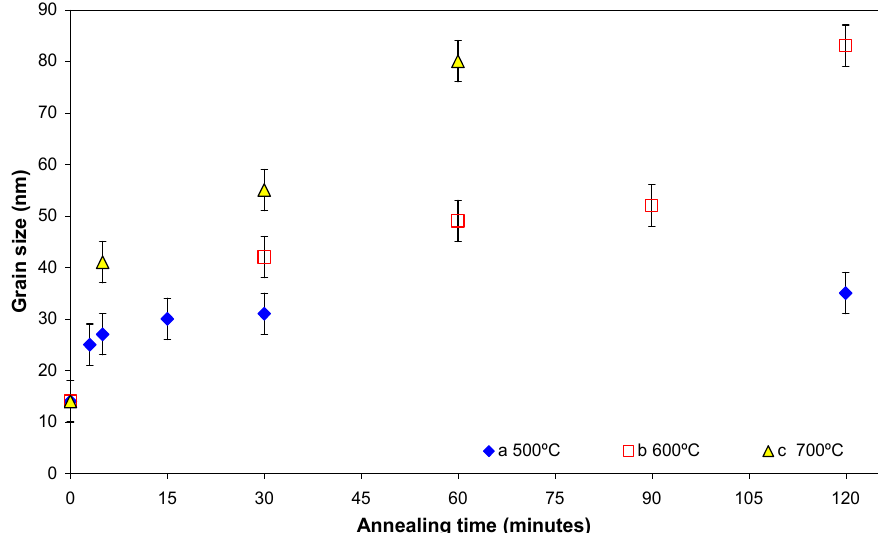
Figure 3. Grain growth of mechanically alloyed Fe-10Cr nanocrystalline alloy powder during annealing at 500 ◦ C ( a ), 600 ◦ C ( b ) and 700 ◦ C ( c ) for different durations up to 120 min ([24], reproduced with copyright clearance].